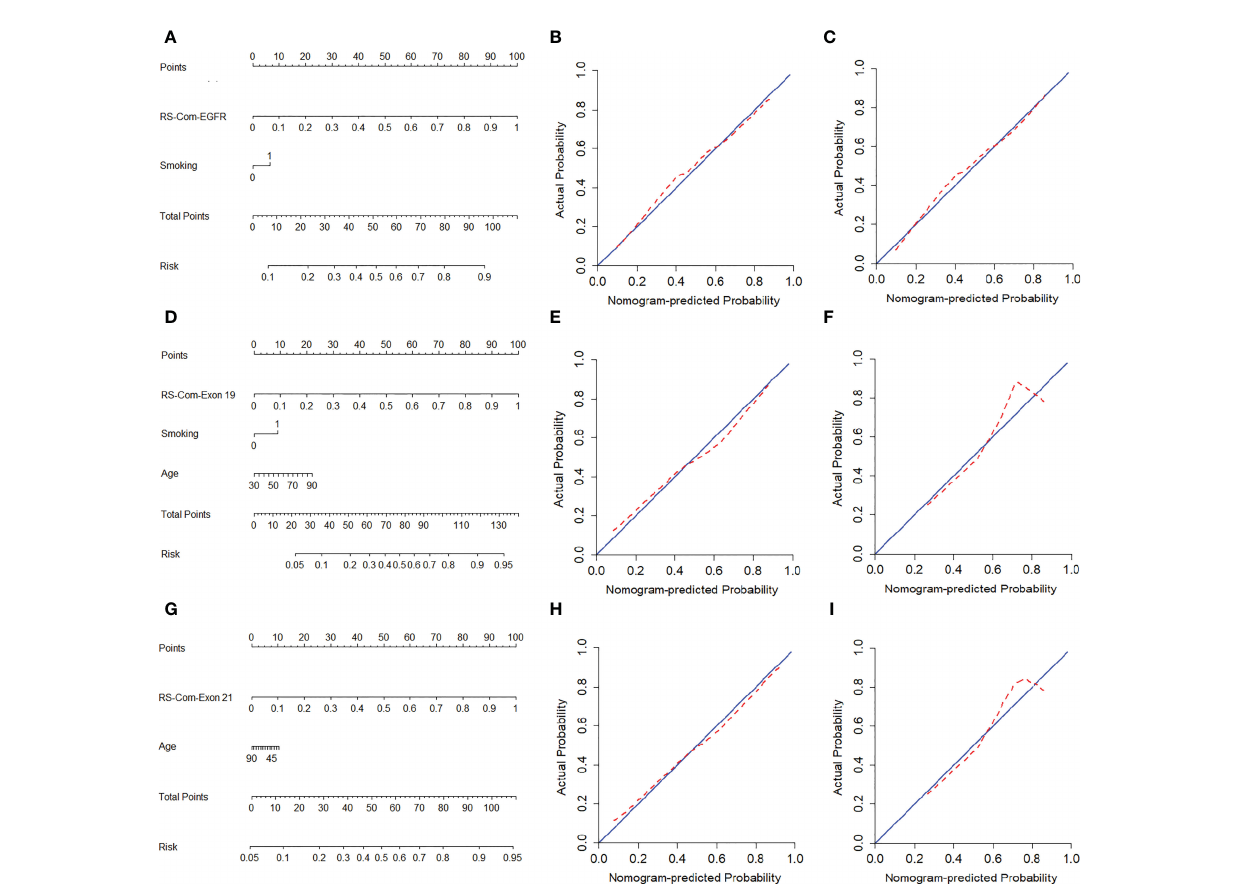
FIGURE 4 Nomogram models for predicting the EGFR mutation and subtypes. (A – C) , nomogram for predicting the EGFR mutation. calibration curves of nomogram in the training (B) and internal validation (C) set. (D – F) , nomogram for predicting the exon 19 mutation. calibration curves of nomogram in the training (E) and internal validation (F) set. (G – I) , nomogram for predicting the exon 21 mutation. Calibration curves of nomogram in the training (H) and internal validation (I) set. The red dotted line indicates the nomogram-predicted performance, whereas the blue line indicates an ideal